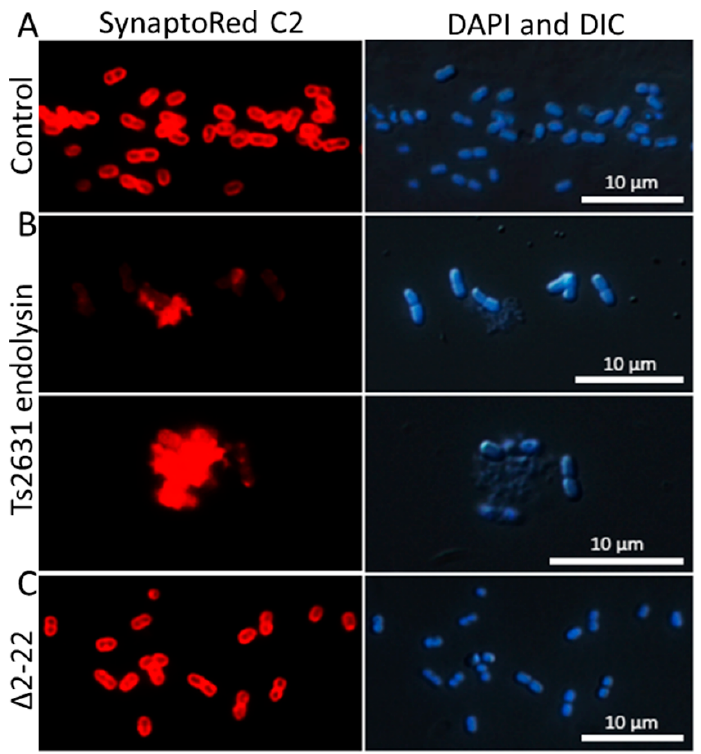
Figure 3. Fluorescence microscopy analysis of A. baumannii KPD 205 cells stained with DAPI (nucleoid) and SynaptoRed C2 (membrane). ( A ) A. baumannii KPD 205 cells incubated with 10 mM potassium phosphate buffer, pH 8.0. ( B ) Bacteria treated for 1.5 h either with 7.4 μ M of Ts2631 endolysin or ( C ) with an equal amount of the Ts2631 Δ 2–22 variant. After the Ts2631 endolysin treatment, the DAPI and DIC images also showed an unaltered bacterial cell shape, except for the cell debris. These bacteria were not visible by SynaptoRed C2 staining, which indicates extensive bacterial membrane damage. DAPI—4 ′ ,6-diamidino-2-phenylindole; DIC—differential interference contrast. Bar indicates 10 μ m.